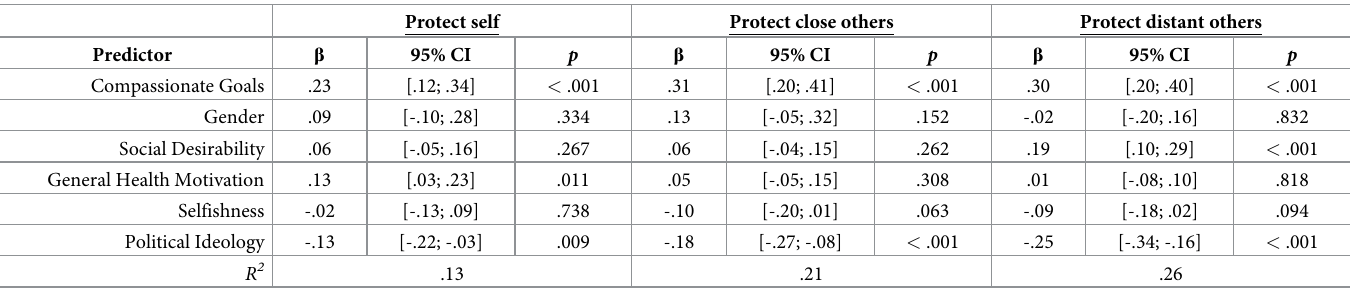
Table 7. Coefficients from multiple regression models predicting reasons for COVID-19 health behaviors in Study 2.